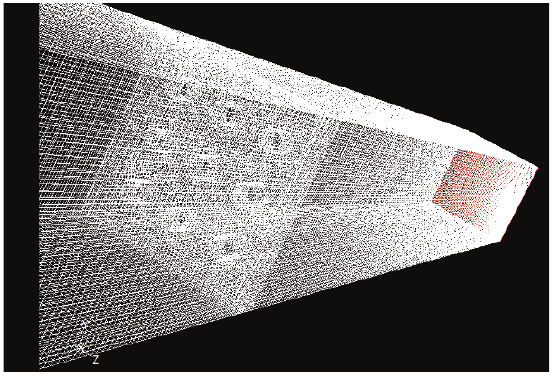
Figure 3. Computational grid: 5x5 in- corridor jets with square shape.